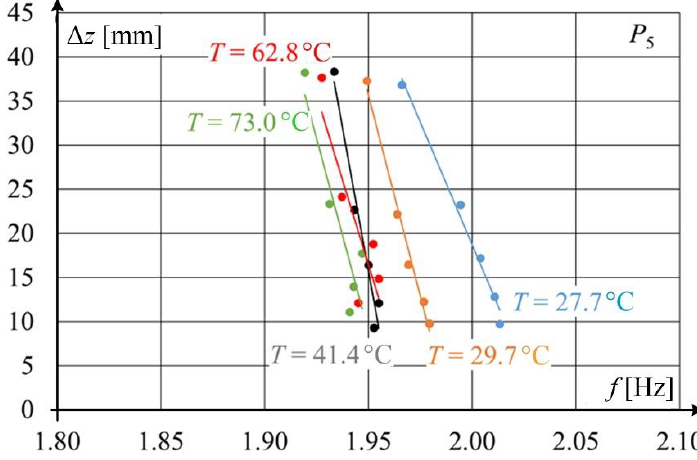
( b ) Figure 15. Spatial distribution of light points for selected recording times and contact wire temper- ature equal to: ( a ) 27.2 °C; ( b ) 73.0 °C.